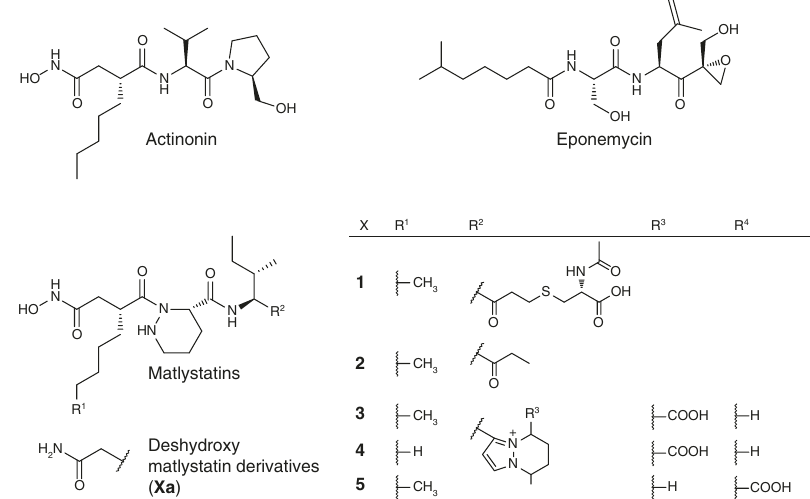
Fig. 1 Chemical structures of selected protease inhibitors. Matlystatin A ( 1 ), matlystatin B ( 2 ), matlystatin D ( 3 ), matlystatin E ( 4 ), and matlystatin F ( 5 ) NATURE COMMUNICATIONS | 8: 1965 | DOI: 10.1038/s41467-017-01975-6 |